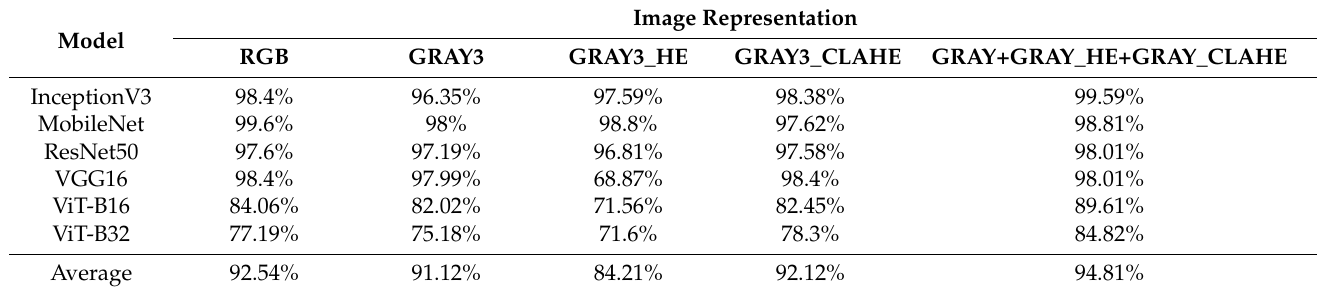
Table 6. F1-score of the models across various image